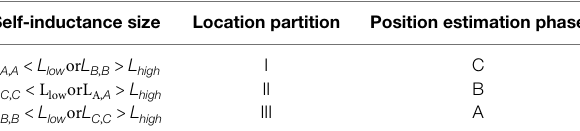
TABLE 1 | Self-inductance sub-region